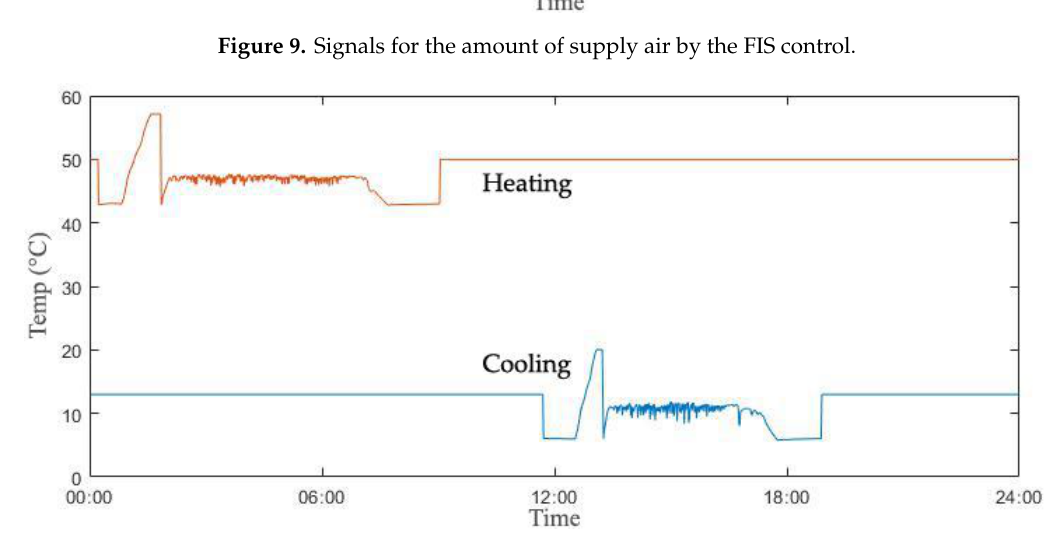
Figure 10. Signals for the temperature of supply air by the FIS control.